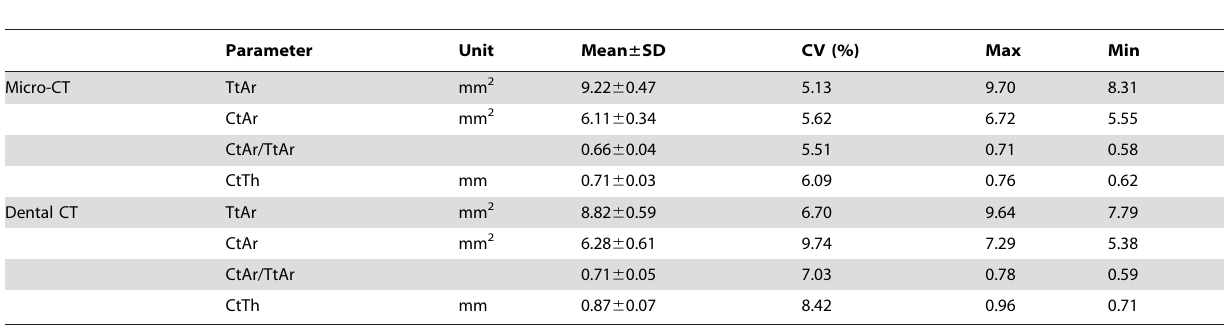
Table 3. Cortical bone parameters of the femoral diaphysis: the four cortical bone morphology parameters (TbAr,CtAr, CtAr/TbAr, and CtTh) measured by micro-CT and dental